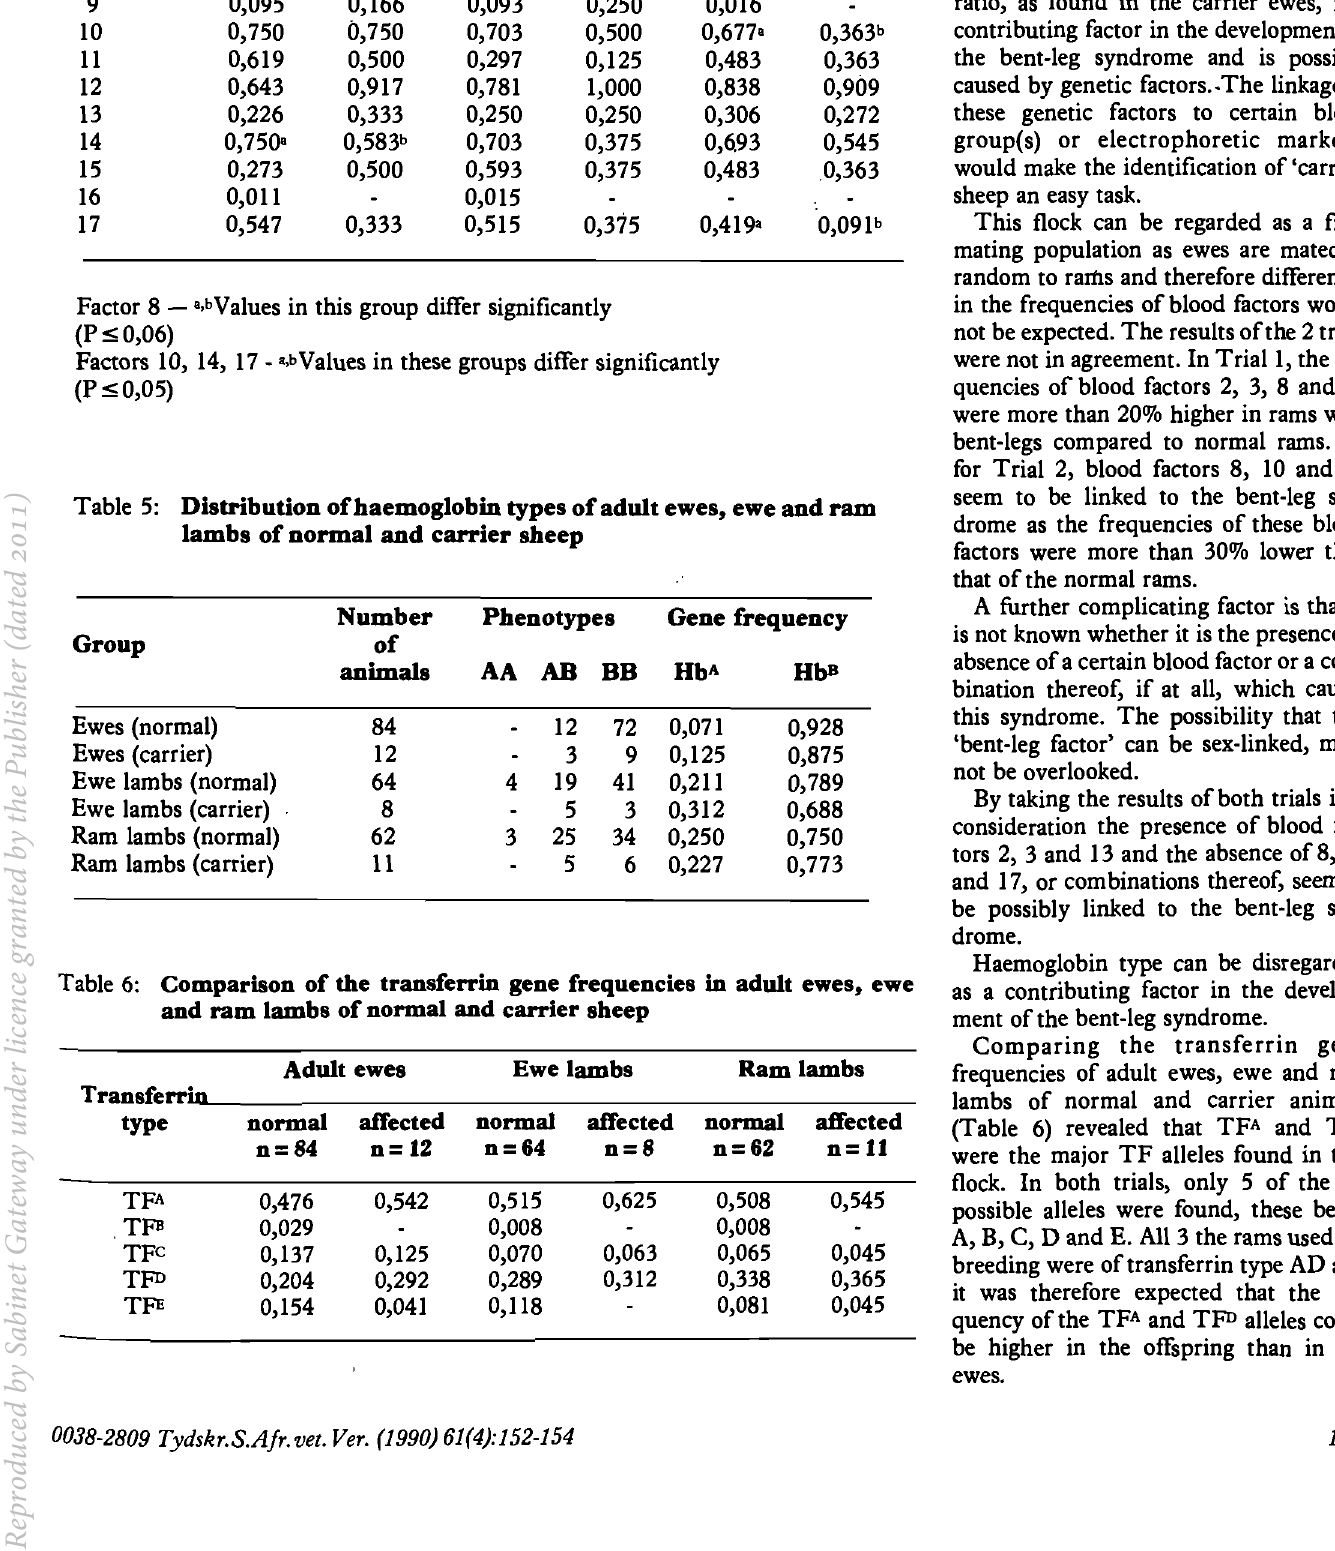
Table 4: A comparison of the frequency of blood factors between adult ewes, ewe and ram lambs of no~al and carrier sheep Adult Ewes 'Ewe lambs Ram lambs